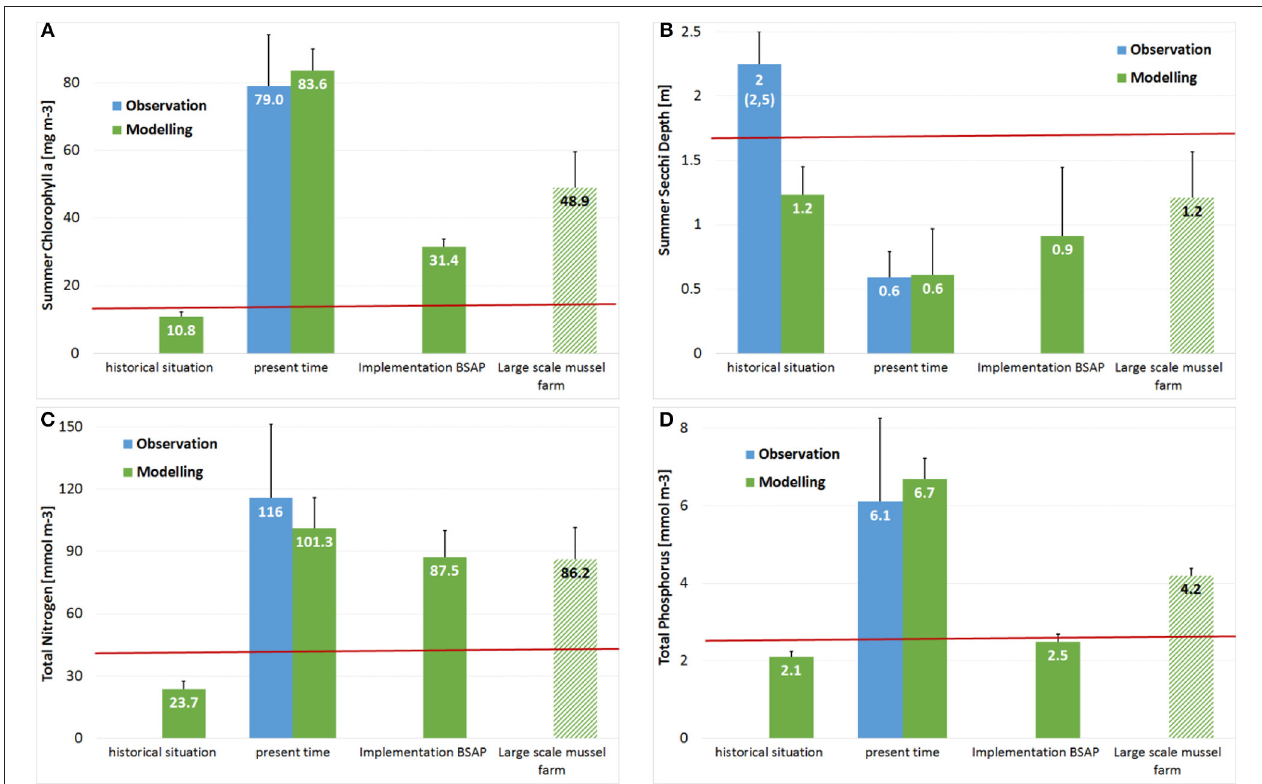
FIGURE 9 | Change of water quality parameters used by EU Water Framework Directive in Small Lagoon assuming the maximal mussel farm option (A) Summer Chlorophyll-a; (B) Summer Secchi Depth; (C) Total Nitrogen; (D) Total Phosphorus in comparison to the GES-thresholds ( Table 1 ; red lines), the historical and present states, as well as a future state assuming the full implementation of HELCOM